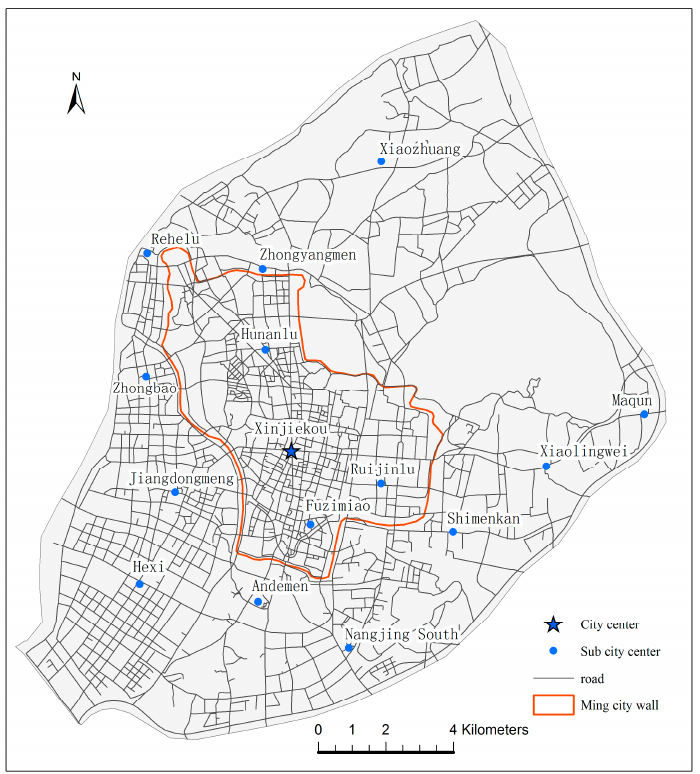
Figure 1. City centers with road network in study area.